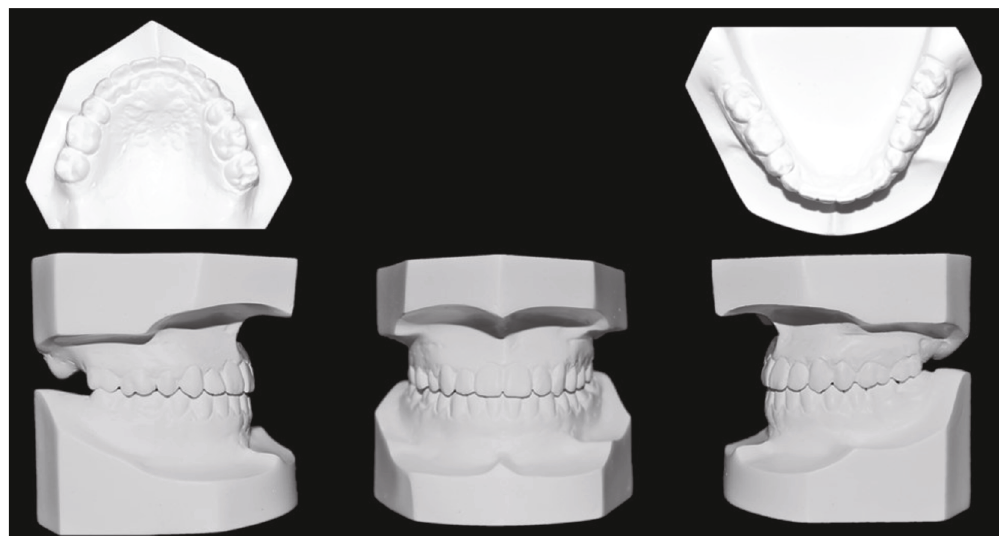
Figure 6: Posttreatment